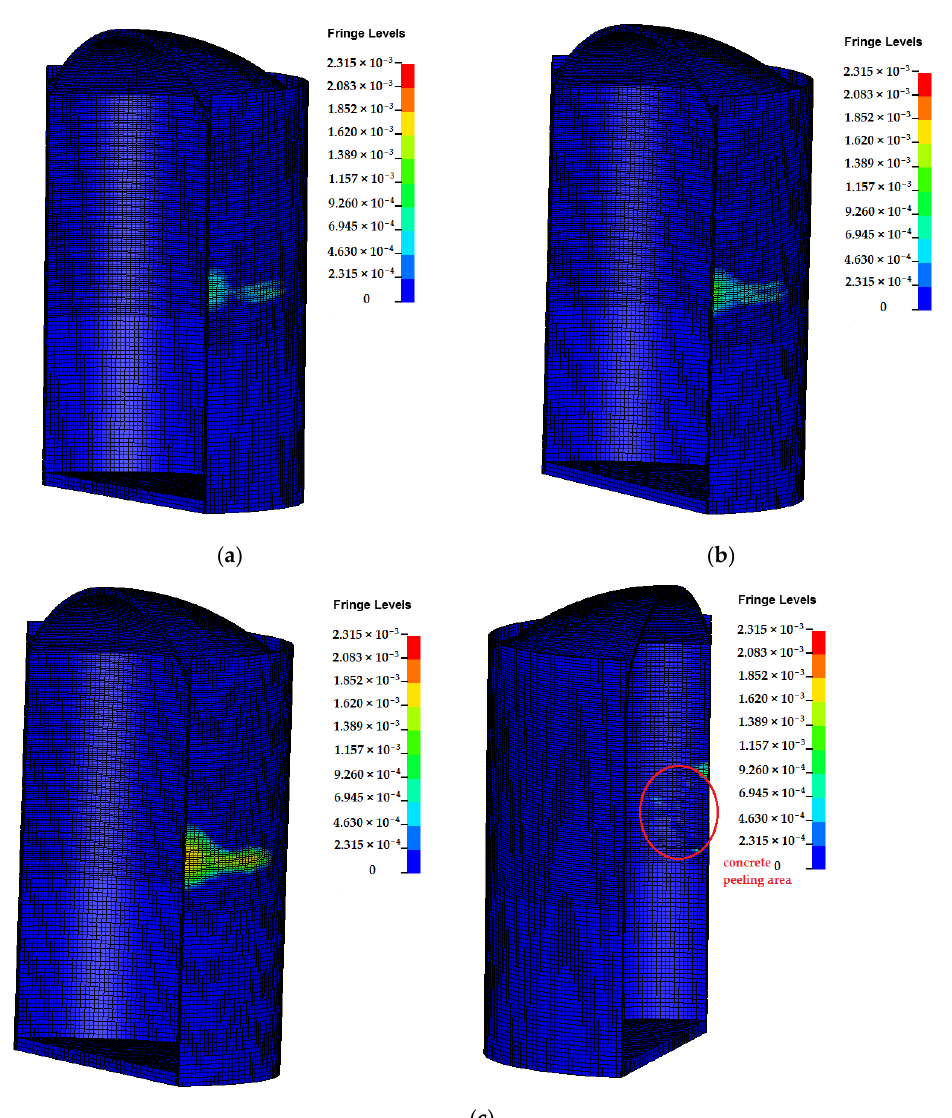
Figure 7. Max plastic strain time-history of concrete.